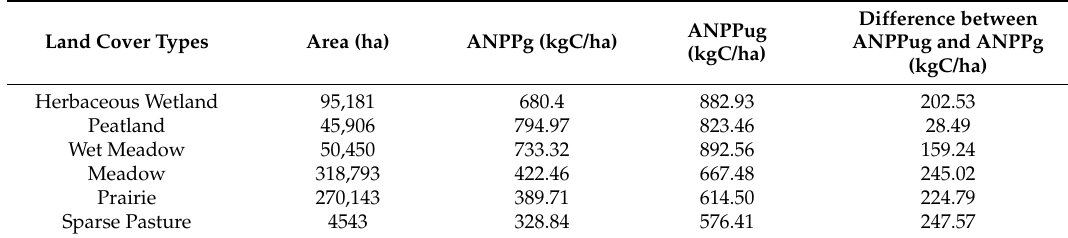
Table 4. The regional average ANPP of the different land cover types in Zoige County considering grazing (ANPPg) and without considering grazing (ANPPug).